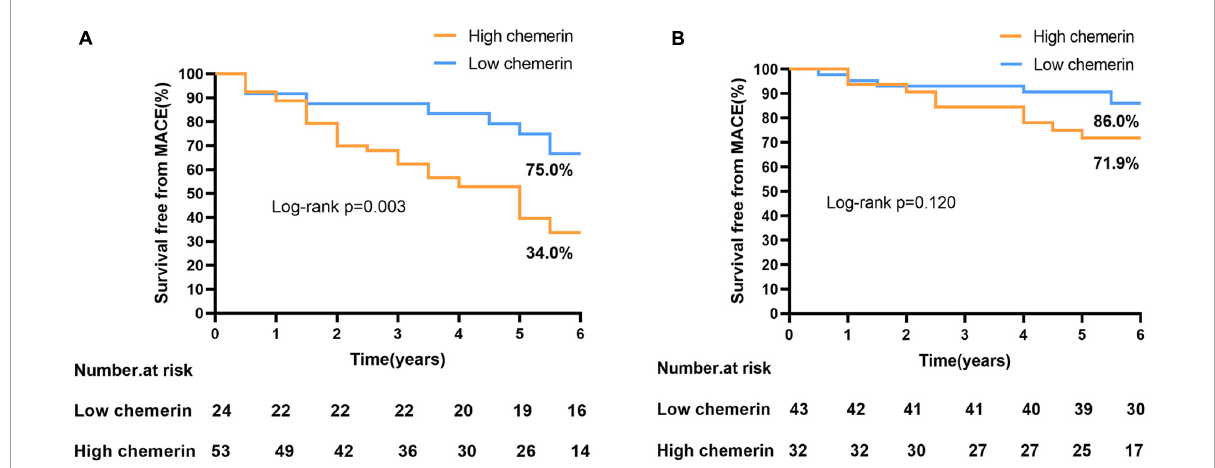
FIGURE3 Incidence of MACEs-free in patients with or without CAD. (A) High/low chemerin in patients with CAD. (B) High/low chemerin in patients with non-CAD. MACEs, major adverse cardiovascular events; CAD, coronary artery